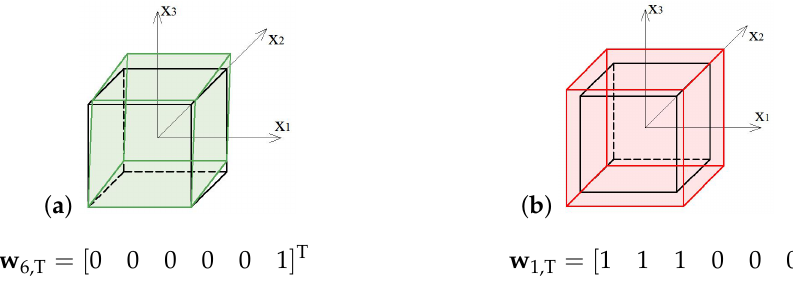
Figure 15. Deformation modes of the truncated tetrahedron: ( a ) Soft mode. ( b ) Stiff mode.